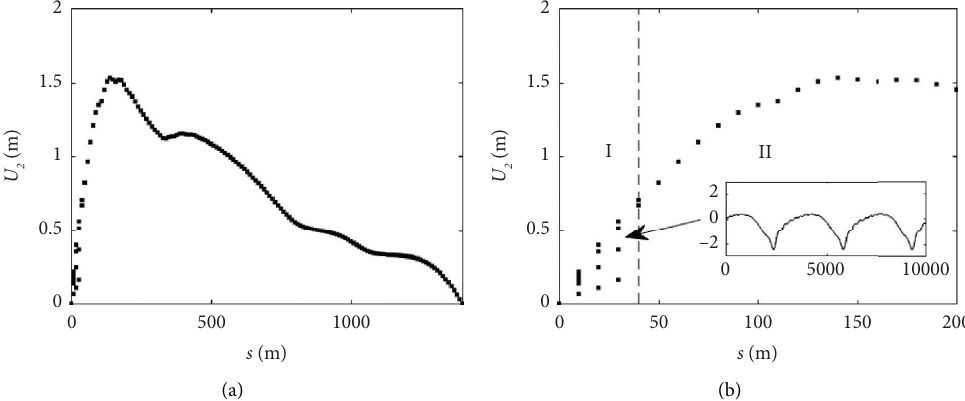
Figure 13: Bifurcation diagram of normal displacement at each position on the cable: (a) the whole mooring structure and (b) partial of mooring structure 0–200m.